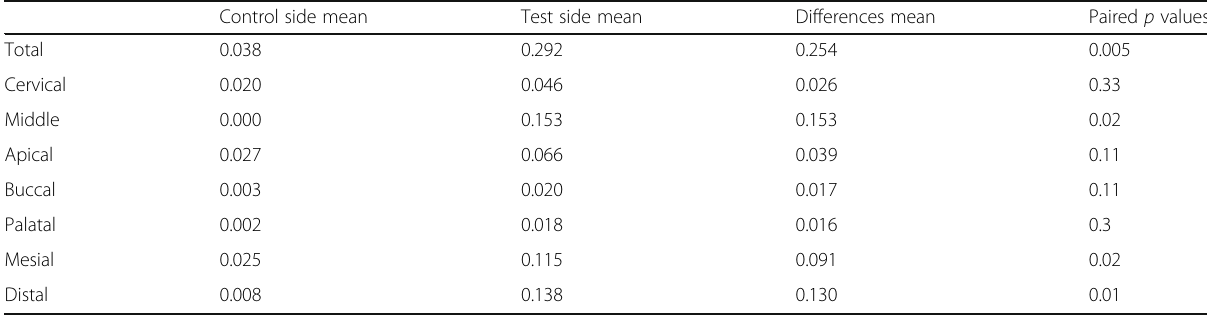
Table 3 Root resorption means and paired t test p values for test and control sites, total, by vertical thirds and by surface Control side mean Test side mean Differences